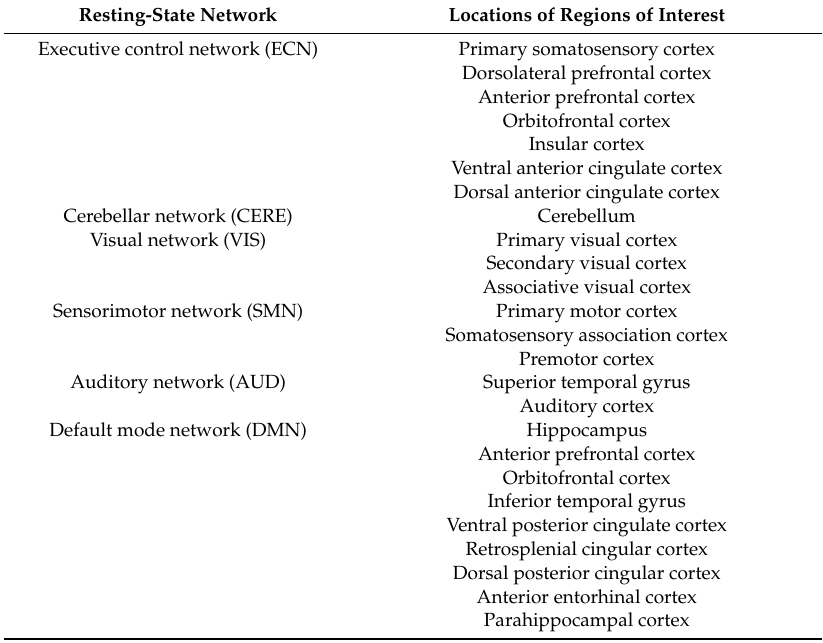
Figure 5. Diffusion tensor imaging analysis. Representative whole brain tractography of piglets born to sows fed a CON (A1, n = 7) or DHA (A2, n = 7) diet during late gestation and lactation. Mean diffusivity (B1), fractional anisotropy (B2), and fiber length (B3) within the hippocampus of piglets. A linear mixed-effect model was used to control for gender (fixed) and maternal (random) effects. Abbreviations: CON: control; DHA: docosahexaenoic acid; MD: mean diffusivity; FA: fractional anisotropy; FL: fiber length. p values higher than 0.1 are not shown on the graph. Table 5. Resting-state network included in the analysis and their regions of